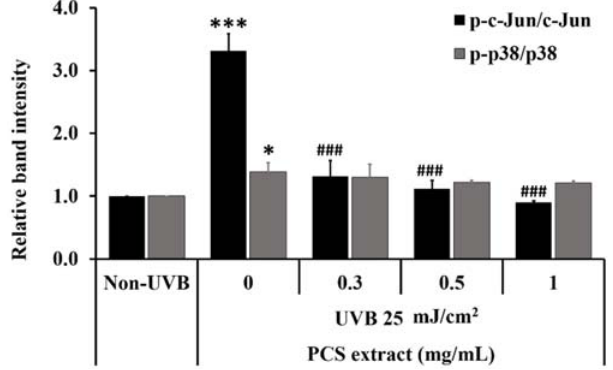
Figure 5. Protective effect of PCS extract on UVB-induced MAPKs phosphorylation in HaCaT cells. After pretreatment of the cells with PCS extract for 1 h, cells were exposed to UVB followed by incubation in fresh medium for 24 h. Then, cells were analyzed by Western blotting. The histogram presents the relative band intensity of a ratio between phosphorylated-form and total-form. Results were the average values ± SD ( n = 3). * p < 0.05; *** p < 0.001 vs. the non-UVB group and ###; p < 0.001 vs. the UVB control group.